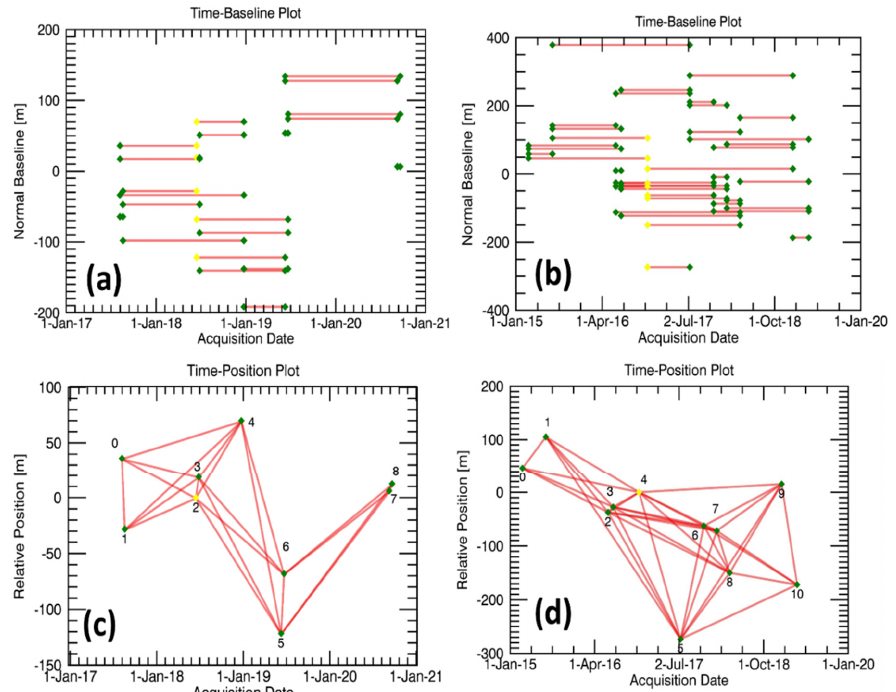
Figure 3. Flowchart of SBAS-DInSAR processing steps.